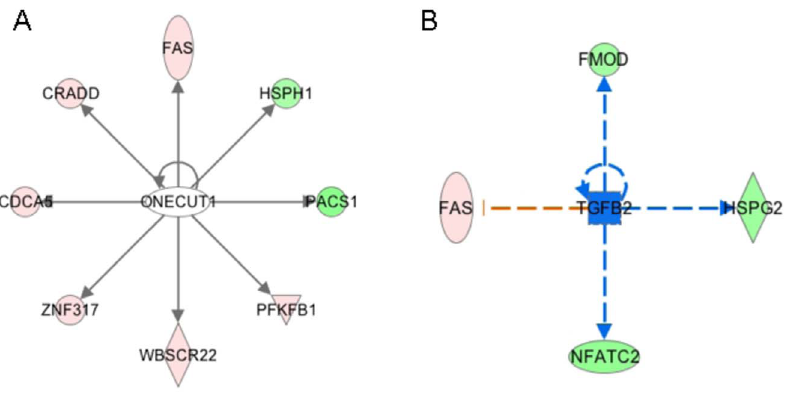
Figure 3. Predicted upstream regulators of Scx in remodeling heart valves. Ingenuity software analysis of differential gene expression changes ( . 1.5-fold change, p , 0.05) in Scx -/- samples to predict upstream regulators of Scx. Based on Ingenuity prediction software, the molecule shapes indicate: ellipse=transcriptional regulators, triangle=kinase, circle=other, square=cytokine, diamond=enzyme. For molecular shape colors: red=upregulated mRNAs, green=downregulated mRNAs, white=no part of dataset, blue=canonical pathway. For lines, solid grey=effect not predicted, dashed line=indirect interaction (blue=positive indirect interaction, orange=negative indirect interaction).